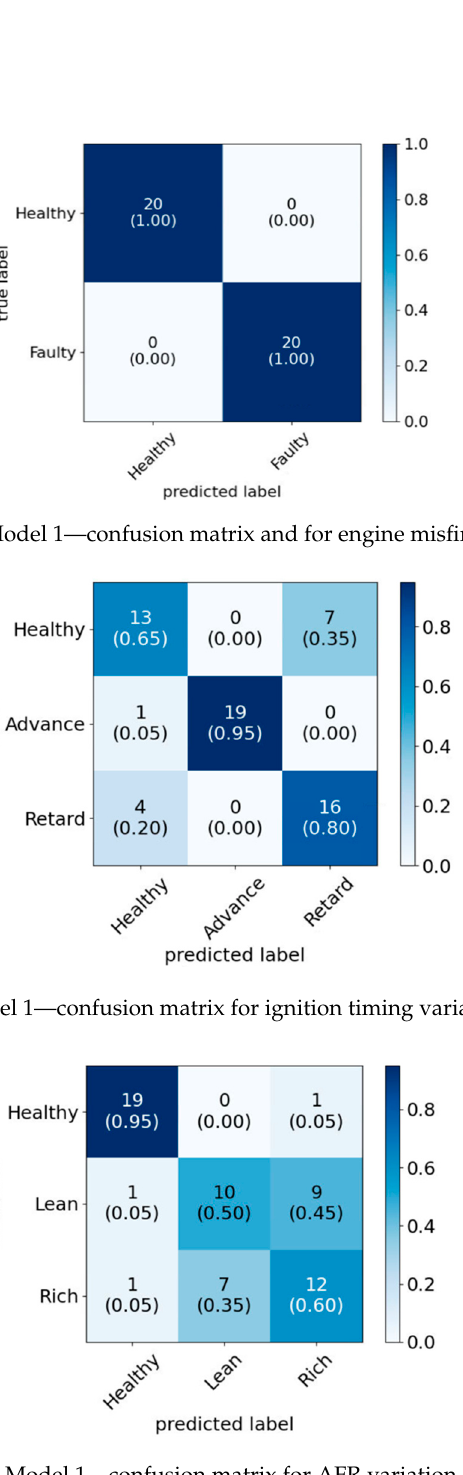
Figure 8. Model 1—confusion matrix for AFR variation data.